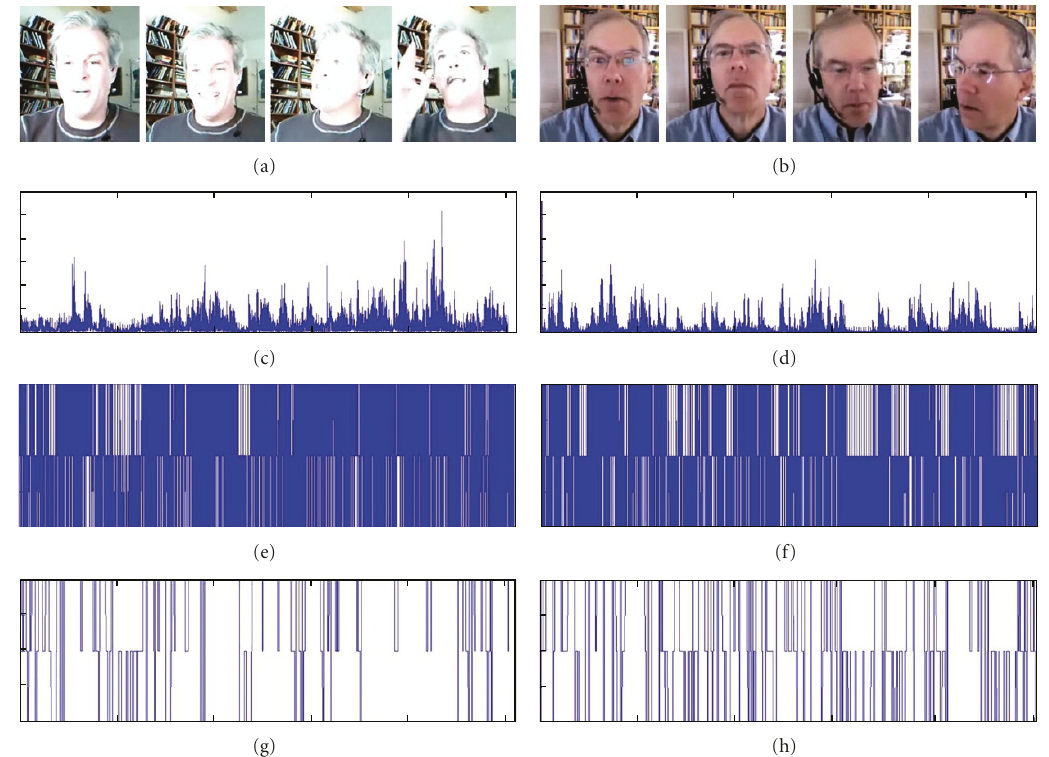
Figure 2: (a, b) Two speakers, (c, d) initial global movement, (e, f) 3-levels post-processing, and (g, h) filtering using window slicing, respectively. The x -axis corresponds to the frame number.